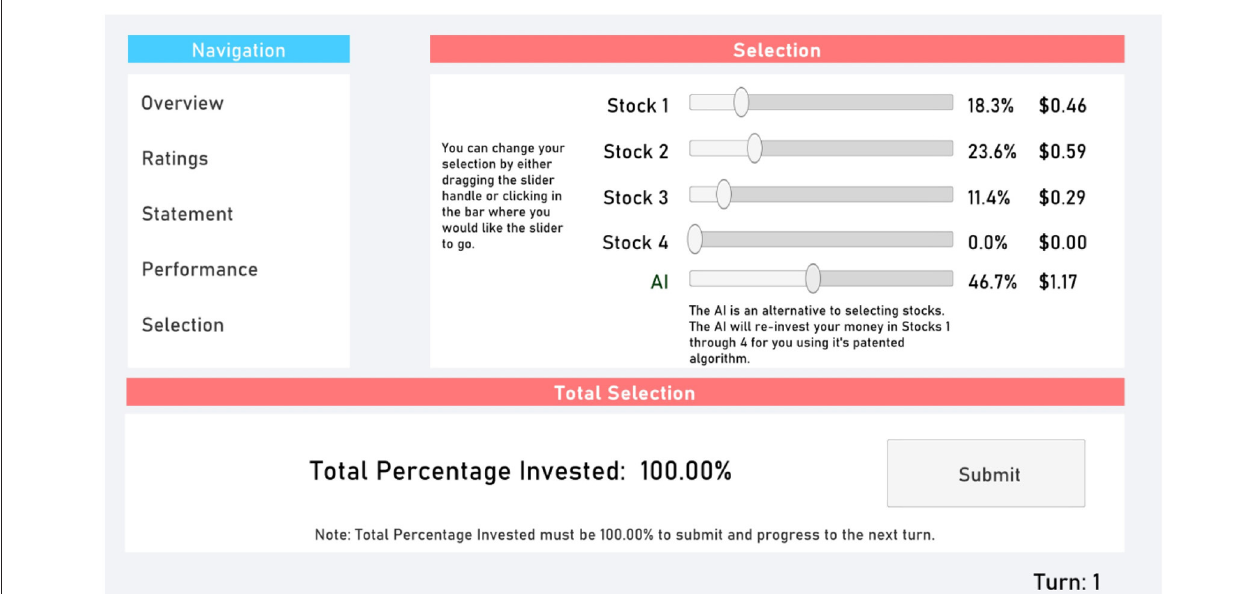
FIGURE 5 | Selection tab.